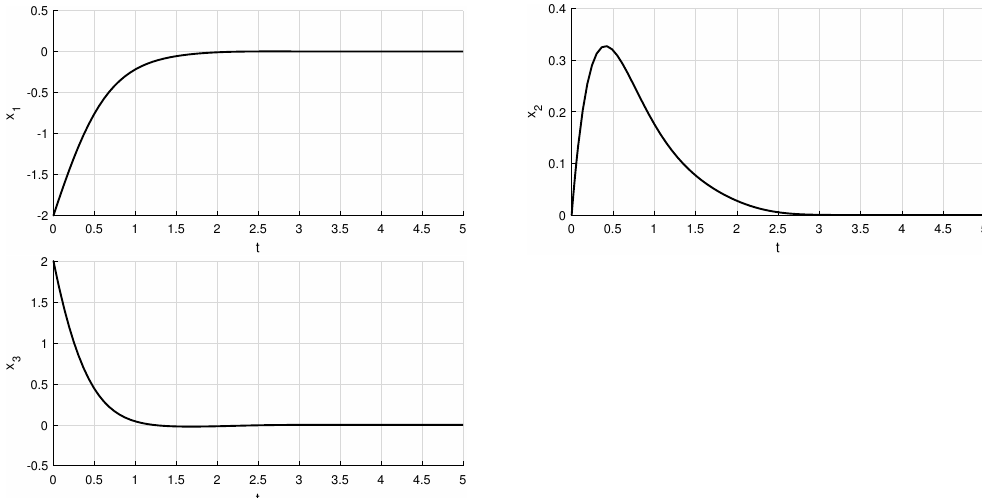
Figure 1. Simulation result for Example 2 with the initial state x ( 0 ) = ( − 2 0 2 ) T . Flow of the state − variables x 1 , x 2 and x 3